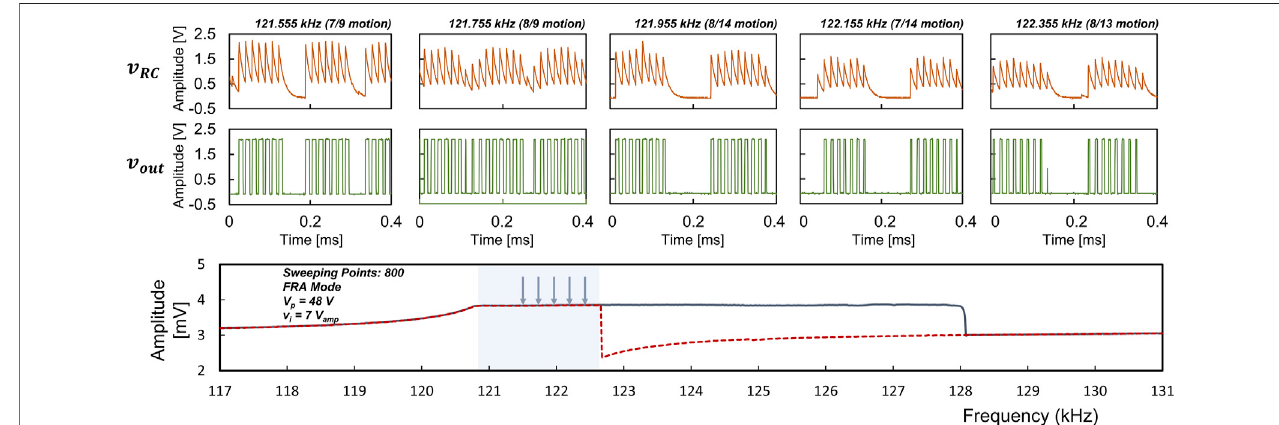
FIGURE 10 | Measured time-domain switching and regulated waveforms along the overlapped area of forward and backward frequency sweepings, showing various period-doubling behaviors. Reproduced from Tsai and Li (2022) with permission from IEEE.